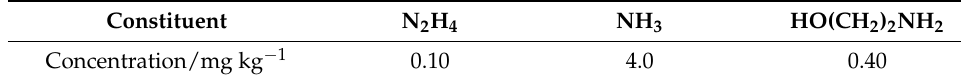
Table 2. Composition of the AMETA